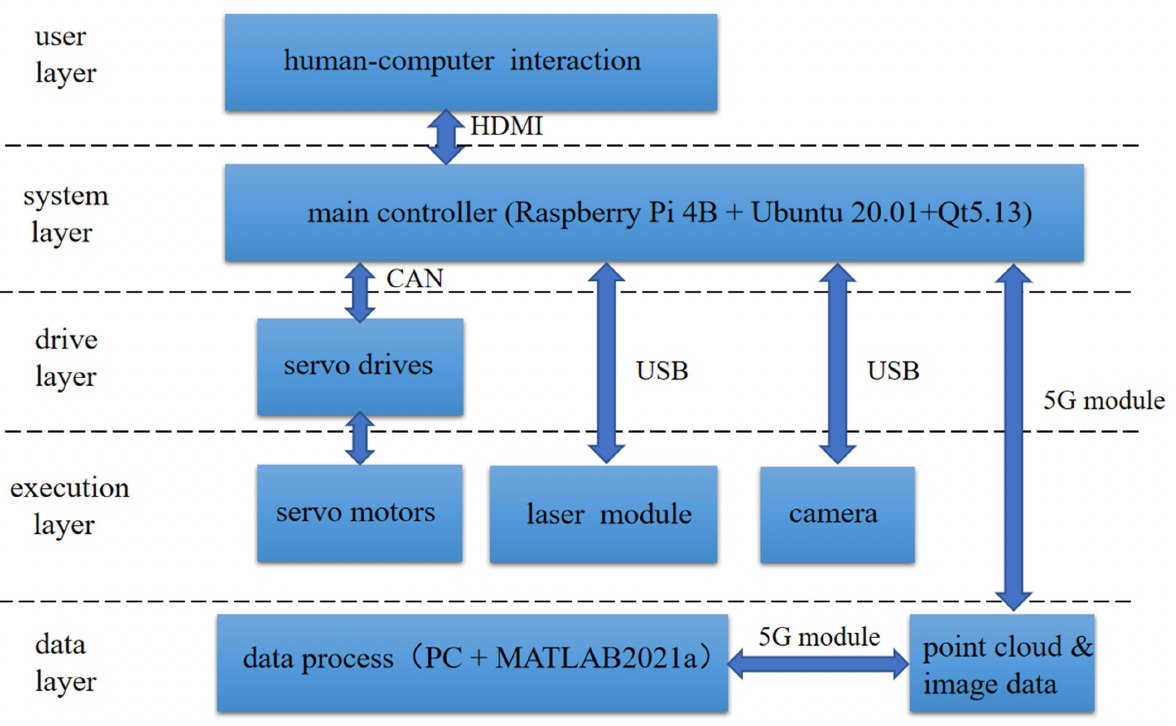
Figure 10. The frame of the indoor quality inspection system; scheme modified for this study from [144].